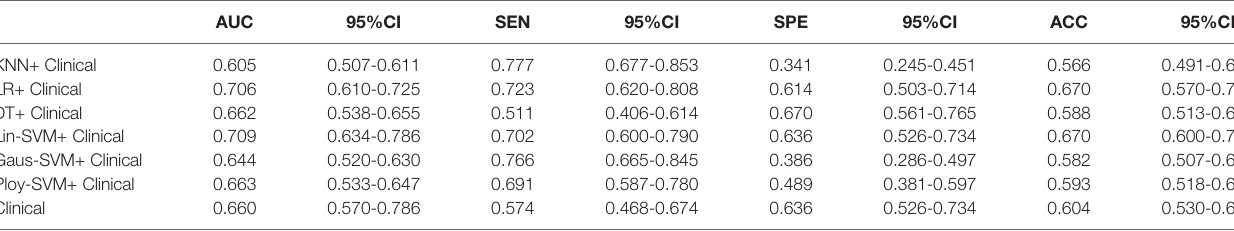
TABLE 3 | The performance of combined models constructed by six algorithms in the internal test set.